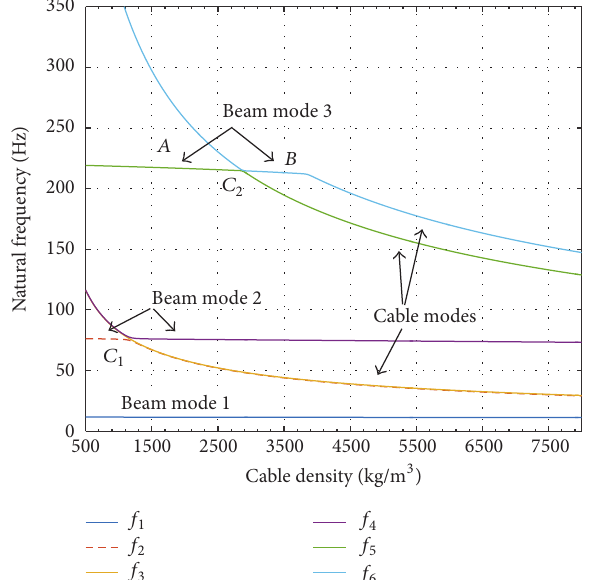
Figure 11: Variation of the natural frequencies with the density of cable, 6 connections, and 𝑘 𝑙 = 10 5 N/m.